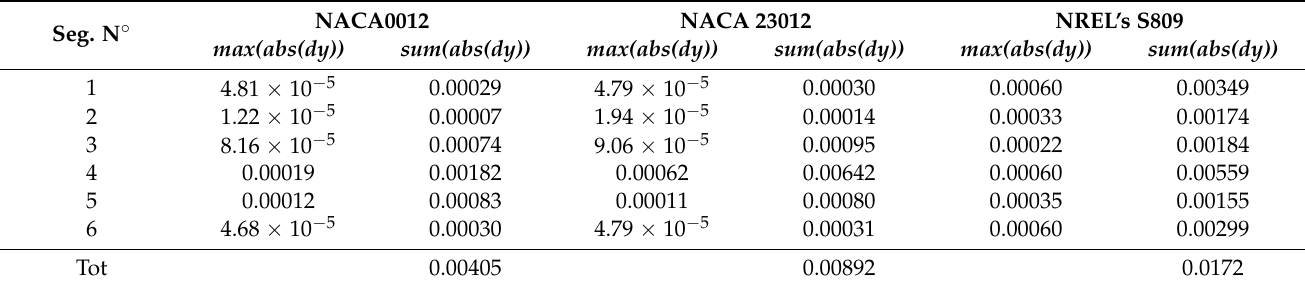
Table 9. New mathematical model fitting process geometrical